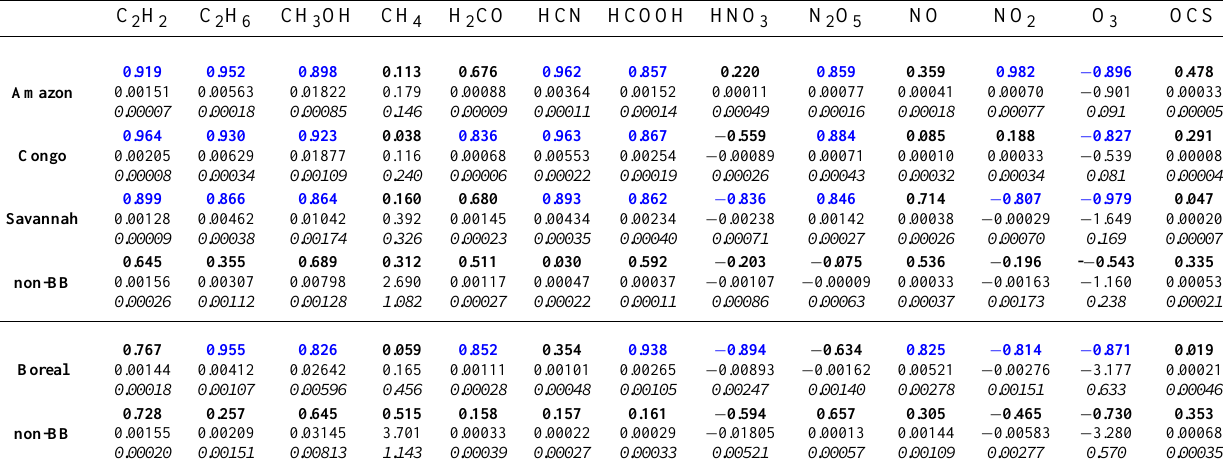
Table 1. Correlation coefficients ( R ) of tracer-CO calculations made from approximately 30 ACE-FTS occultations ( n = 120) of 2–3 day old biomass burning plumes originating from a variety of geographical regions. Beneath each R value is the slope of the linear regression, i.e. enhancement factor and the standard deviation of the slope calculation (in italics). Highlighted in each region are those molecules which correlate highly with CO ( R value ≥ 0.80). Correlations performed on biomass burning emissions can be used effectively to differentiate plumes from different fuels due to their distinct chemical compositions and demonstrates the potential of remotely characterizing biomass burning from different